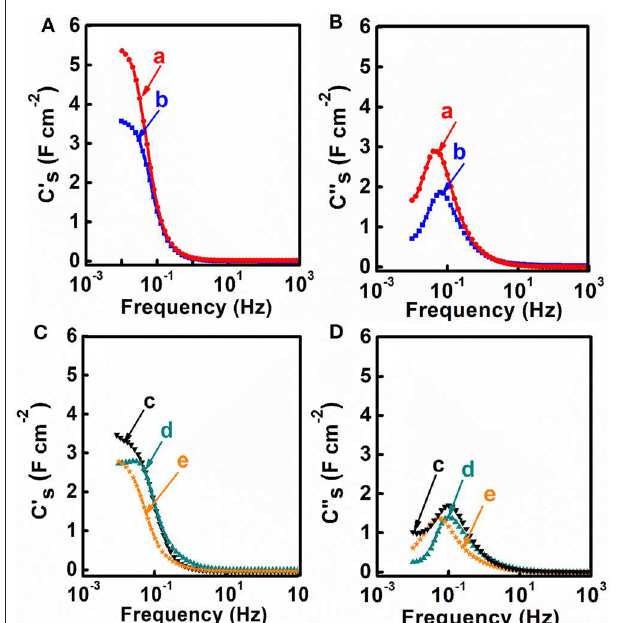
FIGURE 6 | (A–D) Frequency dependences of components of complex AC capacitance, calculated from impedance data for (a) M-CB-MWCNT, (b)